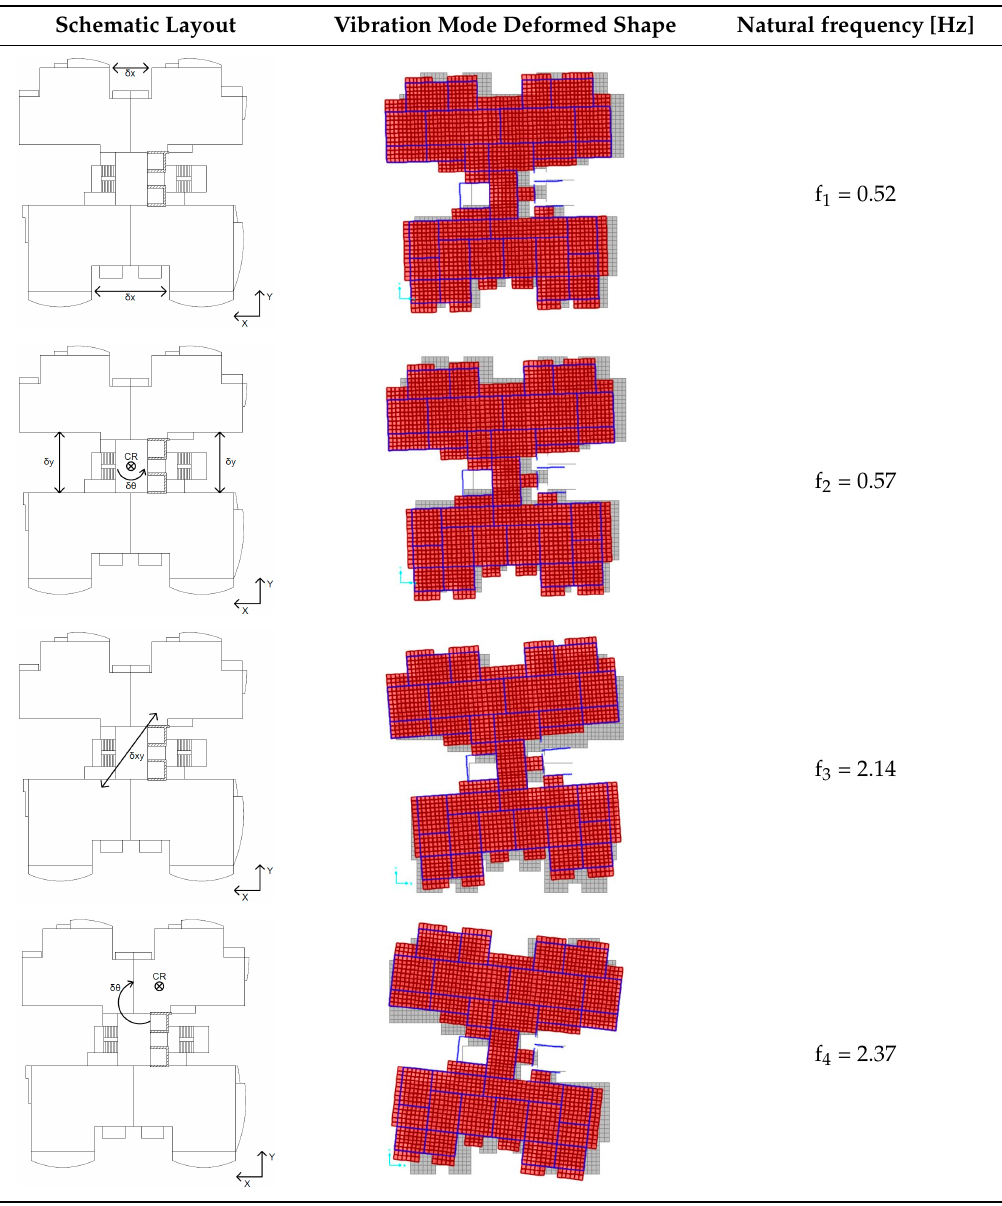
Table 3. Modal analysis results: model without infill masonry walls (Model 1).